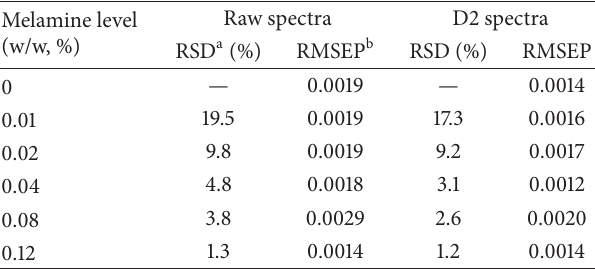
a RSD: relative standard deviation. b RMSEP: root mean squared error of prediction. Table 4: The figures of merit of melamine analysis in 10 different batches of milk powder samples by D2 spectra.